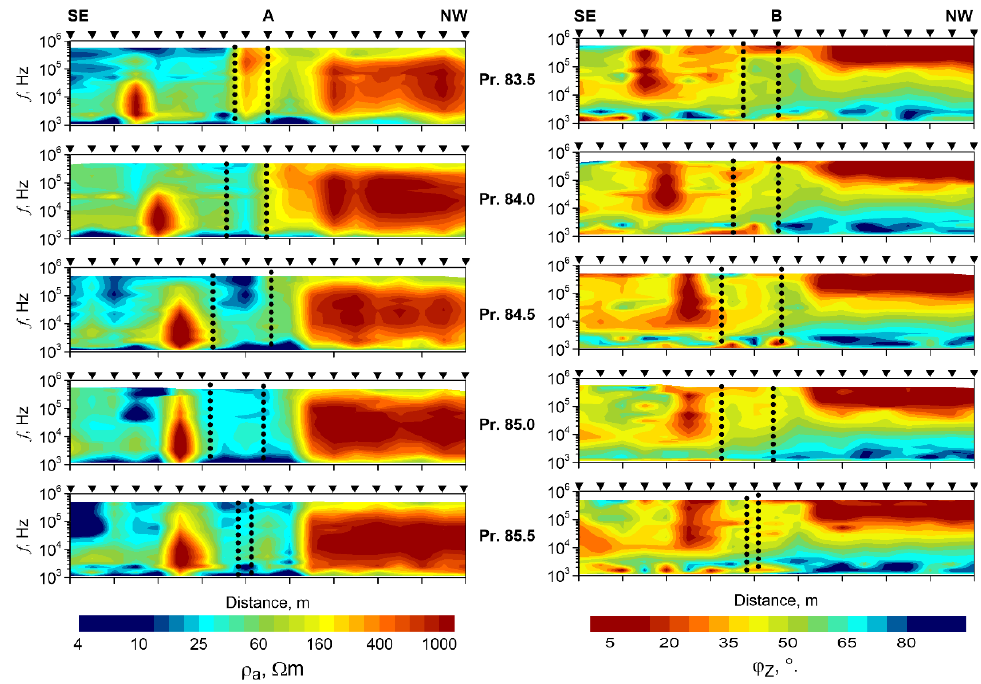
Figure 7. Pseudo-sections of the apparent resistivity ( A ) and impedance phase ( B ) along the profiles at the kimberlite pipe TSNIGRI. Black dashed lines—contour of the pipe, black triangles—sounding stations.